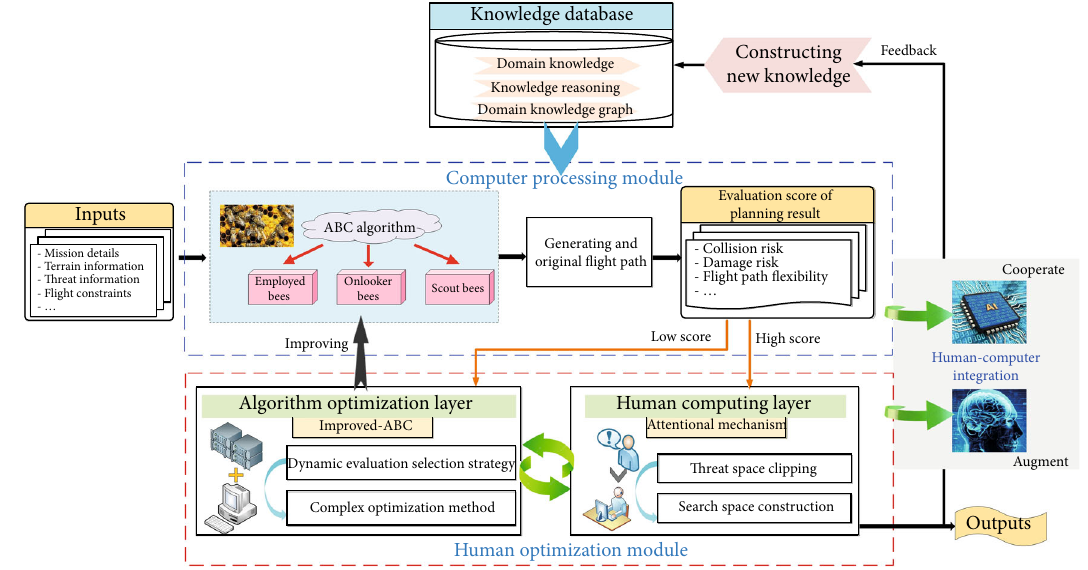
Figure 4: Framework of the human-computer hybrid augmented